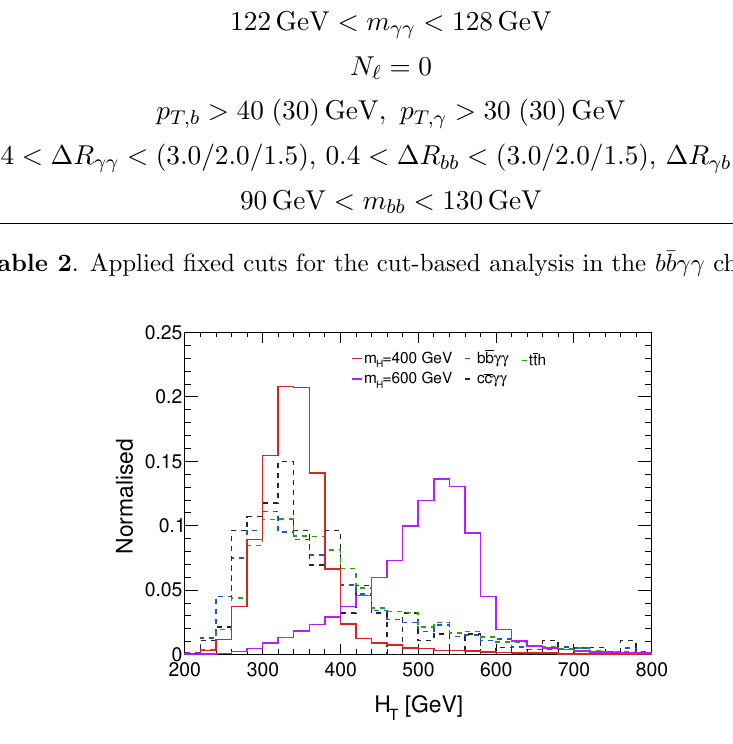
Figure 4 . Normalised distribution of H T for heavy Higgs masses of m H = 400 ; 600 GeV with dominant